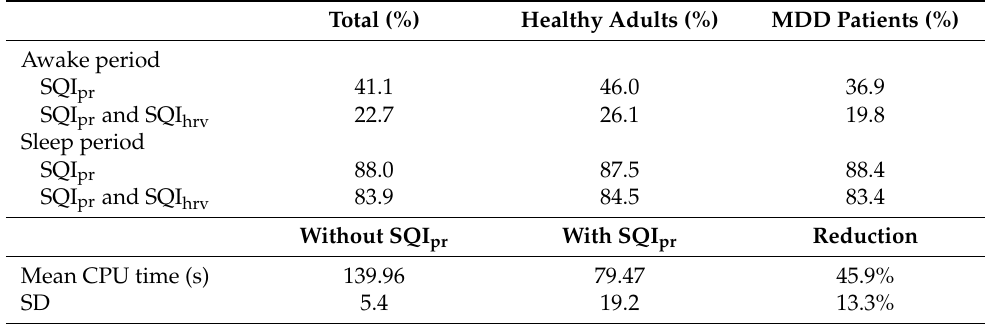
Table 3. Percentages of data remaining and computer processing unit time after thresholding using signal quality indices in the frequency domain.